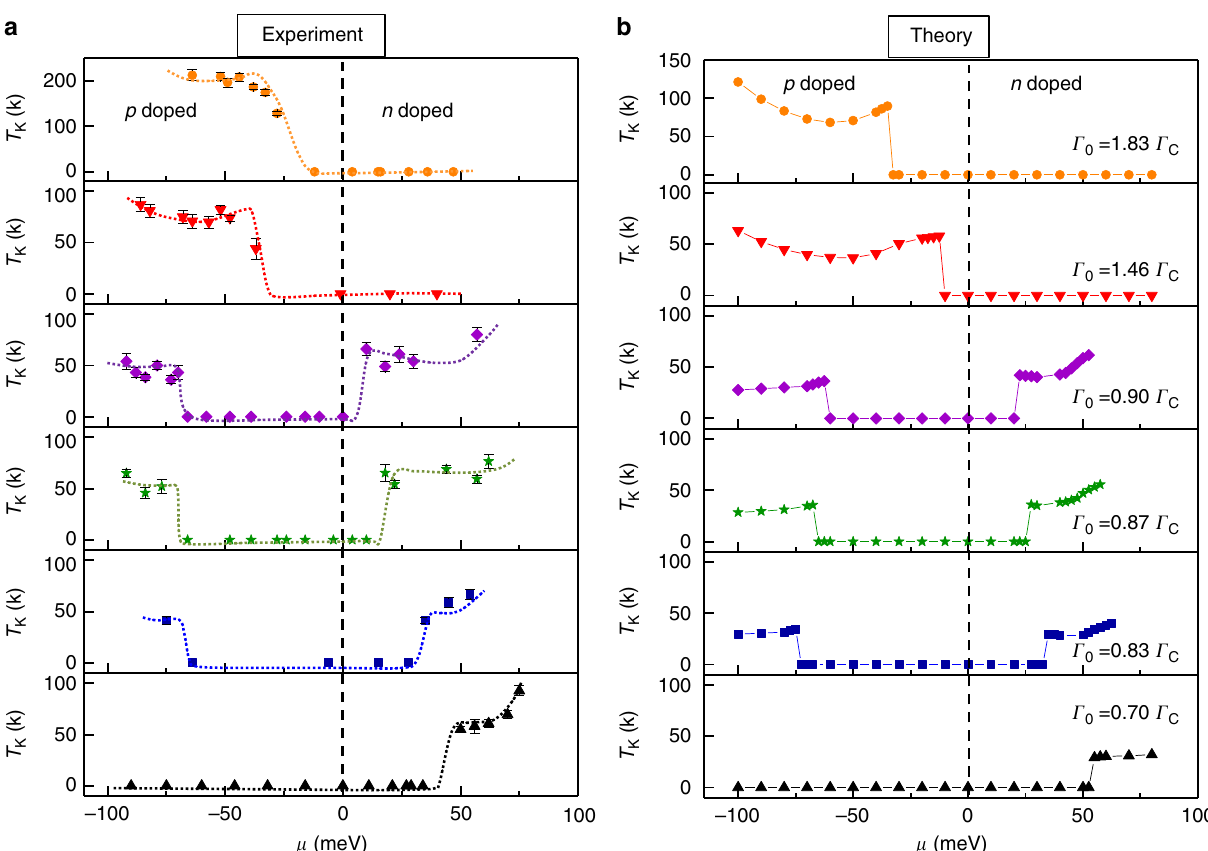
Fig. 3 Chemical-potential dependence of the Kondo temperature. a Chemical potential dependence of T K obtained from the Fano lineshape fi t of the Kondo peak. In the regions where the peak is absent we designated T K = 0. b NRG result for the vacancies in panel a . T K is estimated by fi tting the numerically simulated Kondo peak (Supplementary Note